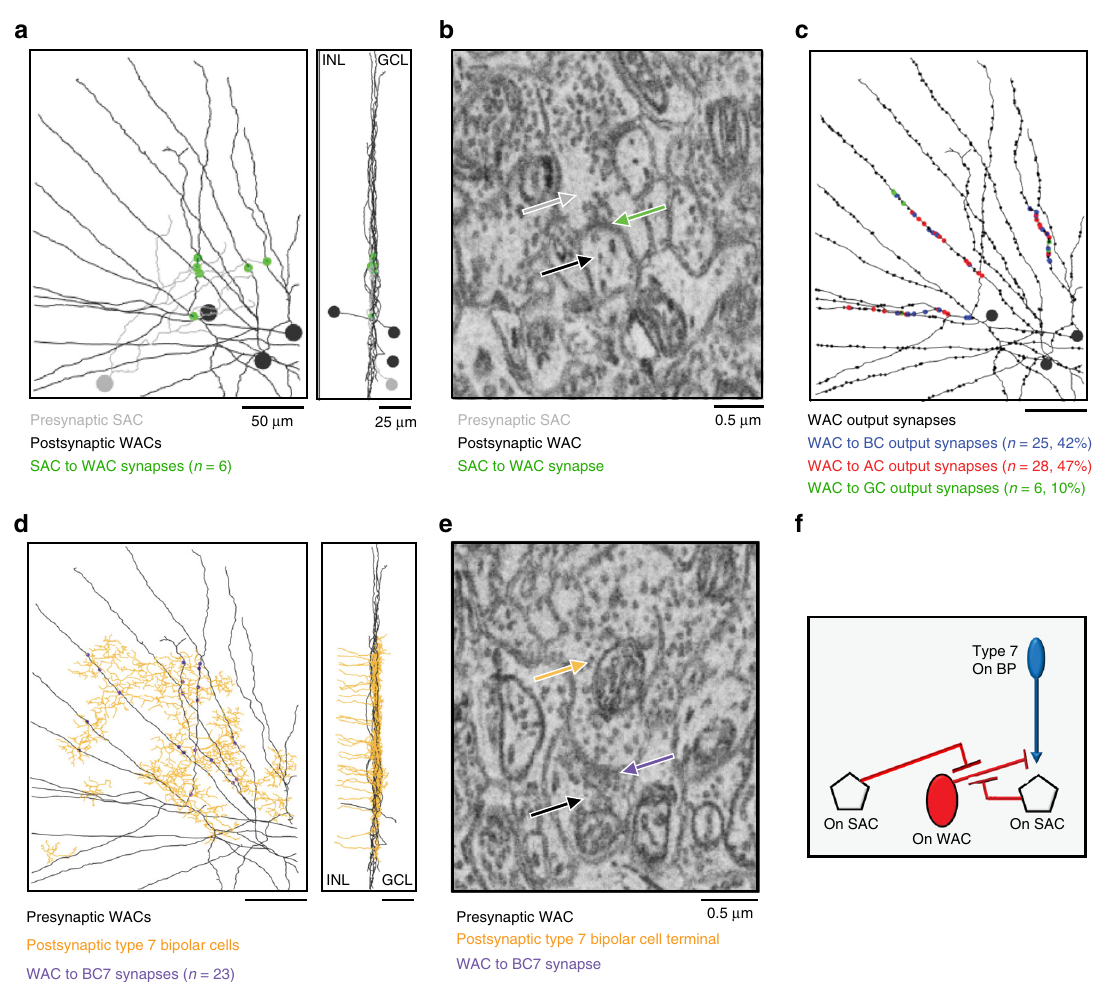
Fig. 7 On SAC – On WAC – On BC – On SAC synaptic motif is detected by connectomic tracing. a Connectomic reconstruction of an On SAC dendritic sector (grey) and 3 of its postsynaptic On WACs (black). Spheres indicate the soma locations of the SAC (grey) and On WACs (black). b An electron microscopy (EM) example of On SAC – On WAC synapse. c Identity of the output synapses from the On WACs reconstructed in a . Color code indicates the n = 59 sampled synapses in which the postsynaptic partner was classi fi ed as either bipolar cell (BC), amacrine cell (AC), or ganglion cell (GC). d Type 7 bipolar cells previously reconstructed in the volume (orange) and the On WACs reconstructed in a (black). Small purple spheres indicated On WAC – BC7 synapses. e An electron microscopy (EM) example of On WAC – BC7 synapse. f Schematic summarizes the On SAC – On WAC – On BC7 – On